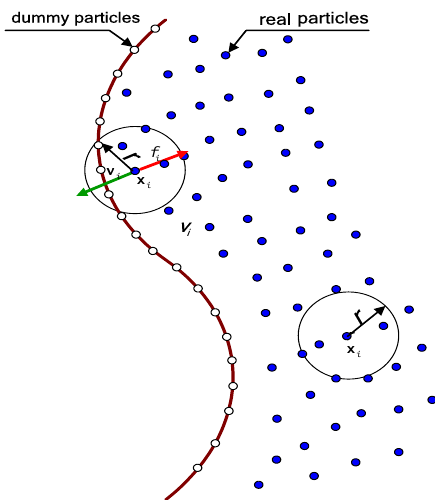
Fig. 1. The interactive relationship of real particle and dummy